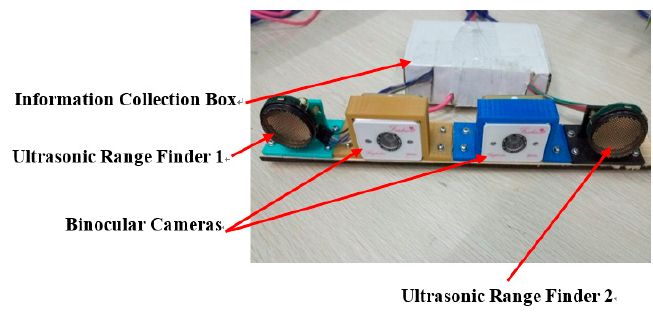
Figure 4. Installation board of multi-sensors.